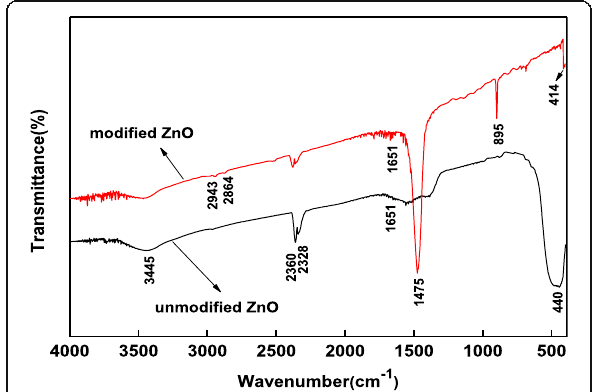
Fig. 3 FT-IR spectra of the unmodified/modified zinc oxide films